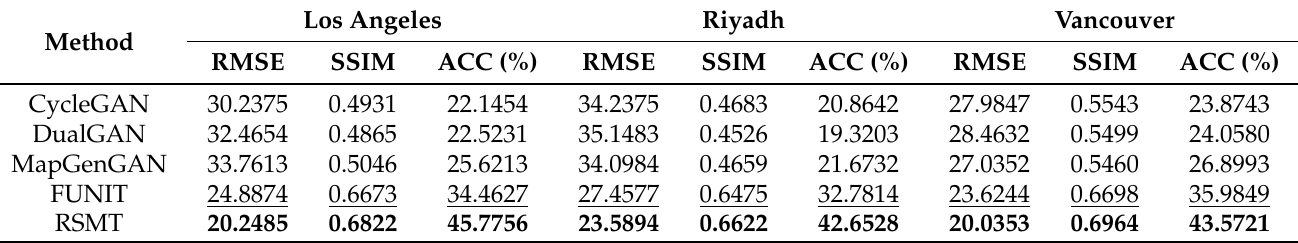
Table 1. Scores for different methods on three testing datasets by three evaluation metrics. RSMT keeps K = 10, compared with other four models by mixed training. (bold: best; underline: